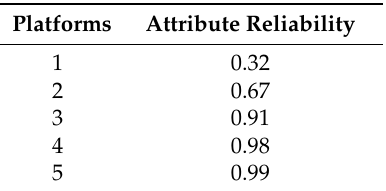
Table 3. Attribute reliability.